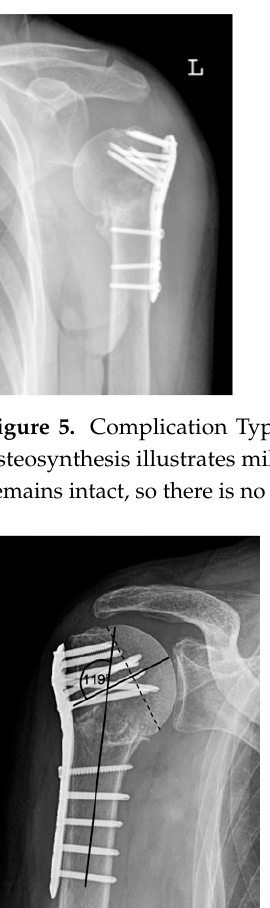
Figure 7. Complication Type 1. sample image. Mild varus displacement of the humeral head after angular stable plate osteosynthesis is shown by the transition of the dashed drawing (initially cor- rect humeral head position) to the prominent black drawing. 3.2.2. Complication Type 2 Complication Type 2 has three di ff erent subgroups. As a common feature, Type 2a and 2c are accompanied by displacement of the humeral head associated with a screw cutout through the humeral head cortex. Type 2b is de fi ned as displacement of the greater or lesser tuberosity or both. Complication Type 2a Complication Type 2a is de fi ned by varus displacement (<20°) of the humeral head associated with screw cutout through the humeral head cortex. The head sintering is con- sidered relatively stable and non-progressive (Figures 8–10).